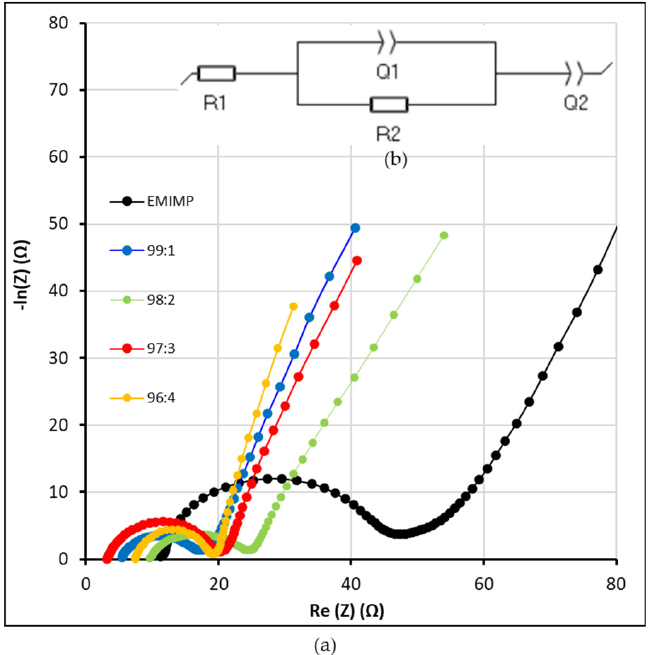
Figure 7. ( a ) Nyquist plots of the different EMIMP/CNFc gel electrolytes and EMIMP ionic liquid; ( b ) Equivalent circuit of the system.